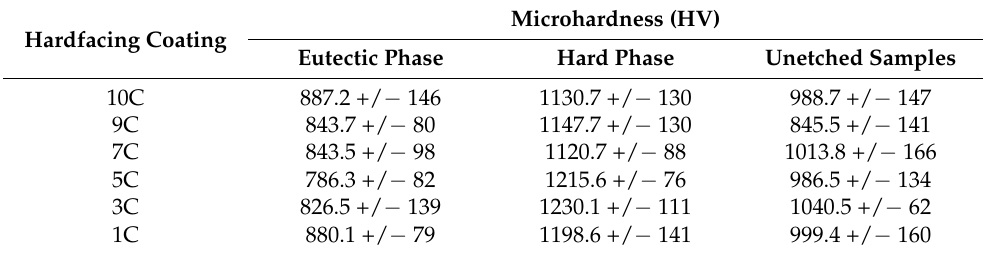
Table 7. Average Vickers hardness values of the sintered